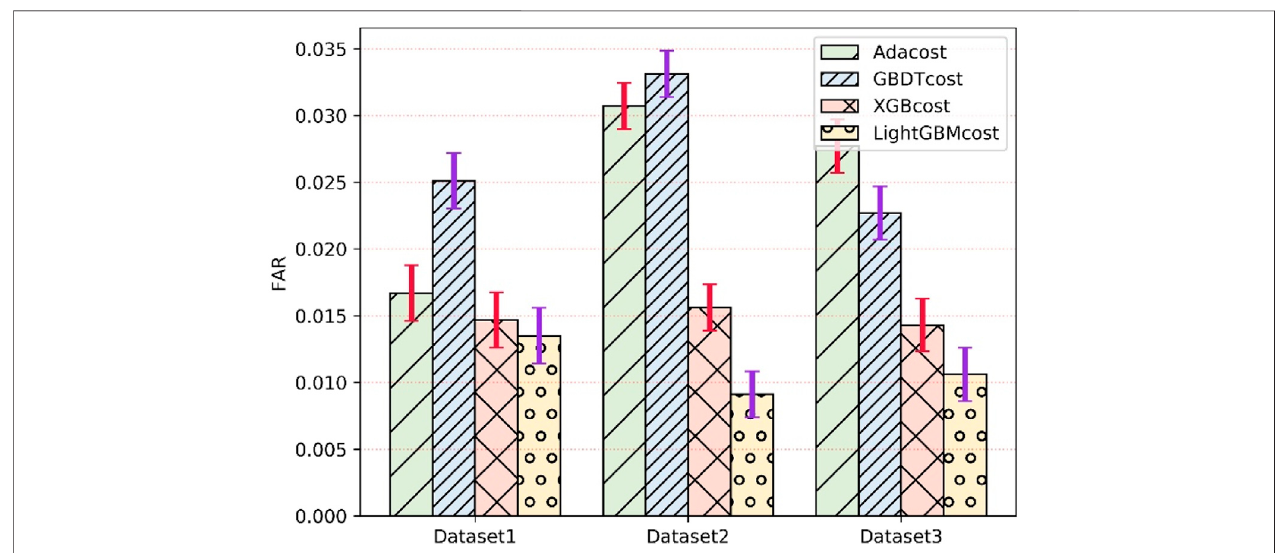
FIGURE 5 | False alarm rate of four algorithms for fault detection of wind turbines gearboxes.